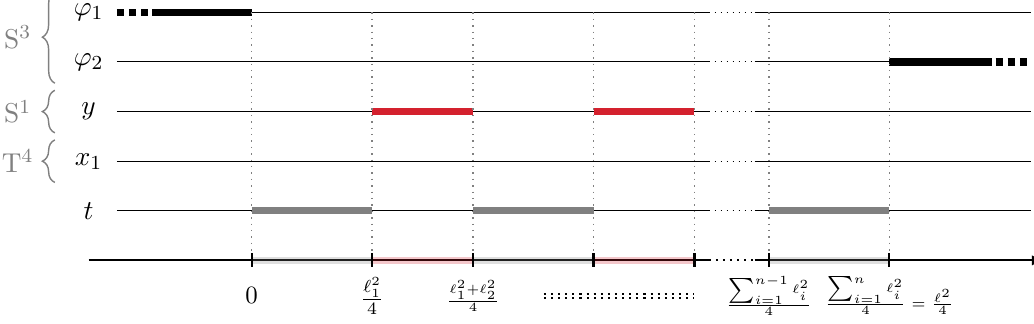
Figure 15 . Rod diagram of the shrinking directions on the z -axis after sourcing the solutions with n connected rods that induce alternatively horizons and bolts where the S 1 shrinks.